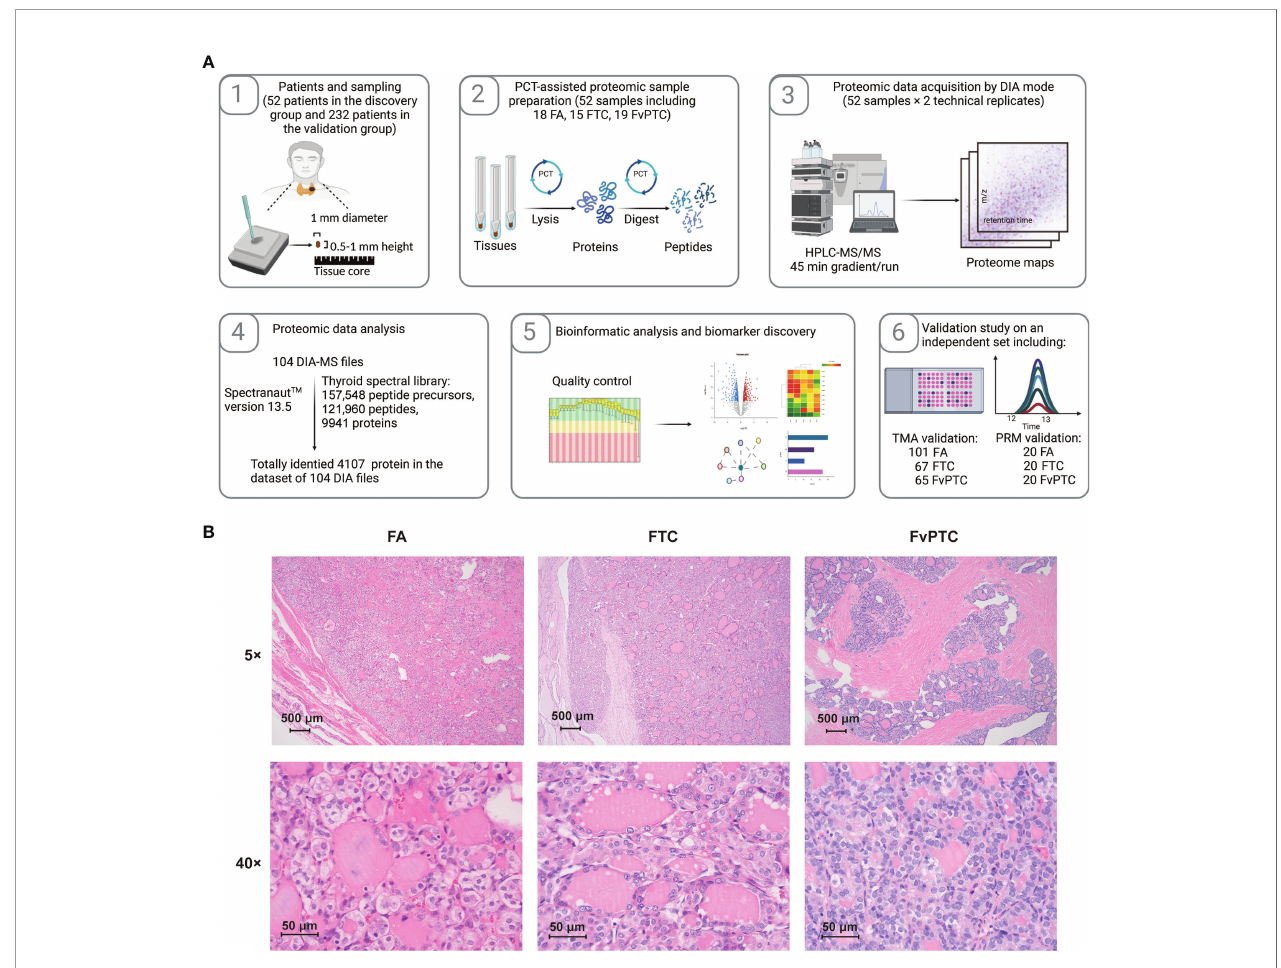
FIGURE 1 | Schematic of the study. (A) Work fl ow of the current study. (B) The histopathological characteristics of FA, FTC, and